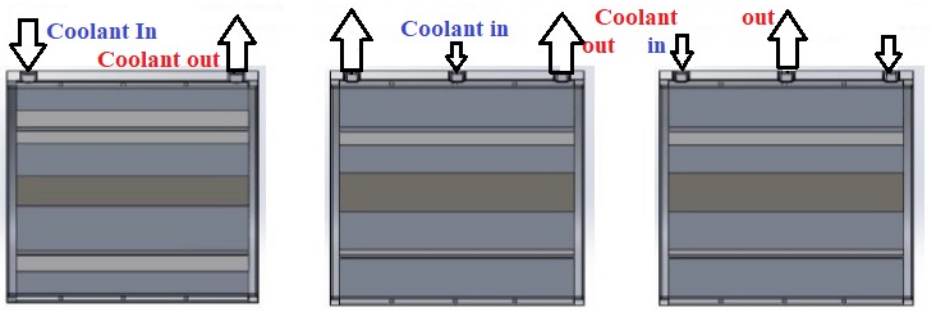
Figure 8. Cooling jacket configuration with different number of passes [40].